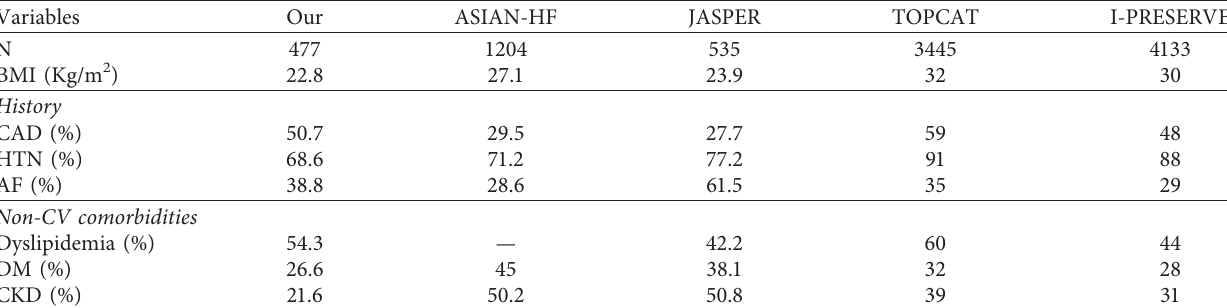
CAD: coronary artery disease; HTN: hypertension; AF: atrial fibrillation/flutter; DM: diabetes mellitus; CKD: chronic kidney disease; BMI: body mass